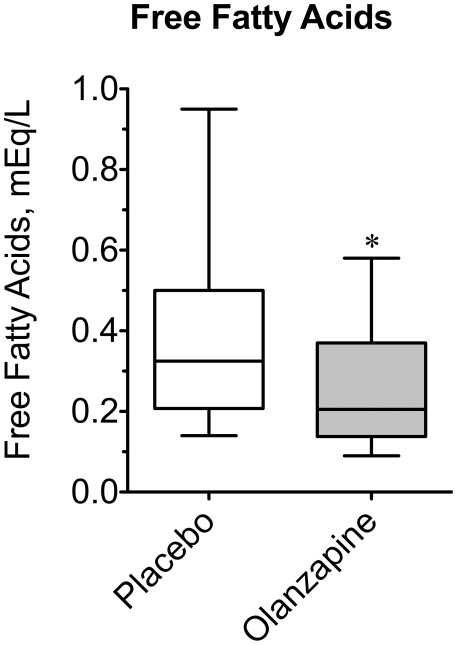
Effect of olanzapine on plasma fasting free fatty acids.Baseline blood samples were collected approximately 10–12 h following the final dose of olanzapine or placebo tablets prior to beginning an oral glucose tolerance test for hormone and metabolite analyses. Plasma free fatty acid concentrations were measured for all subjects under placebo- and olanzapine-treated conditions. Data are expressed as a box plot for placebo and olanzapine-treated groups. An asterisk indicates (P = 0.016) a significant difference between the medians of the placebo and olanzapine groups (n = 15).